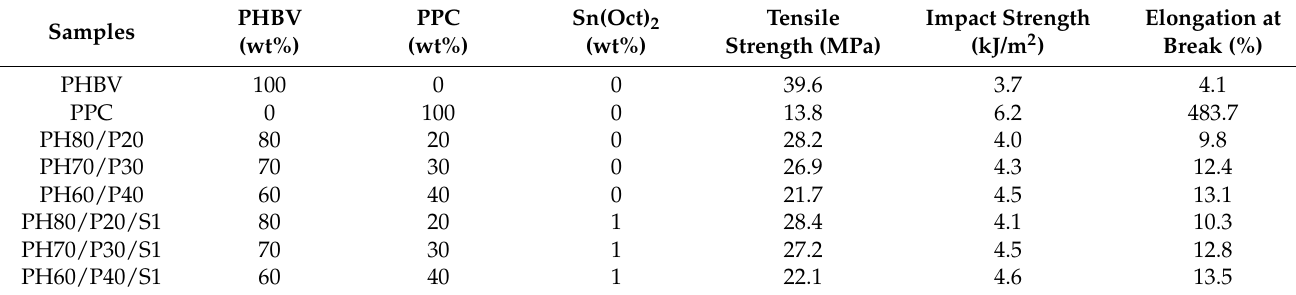
Table 1. Mechanical properties data of PHBV/PPC